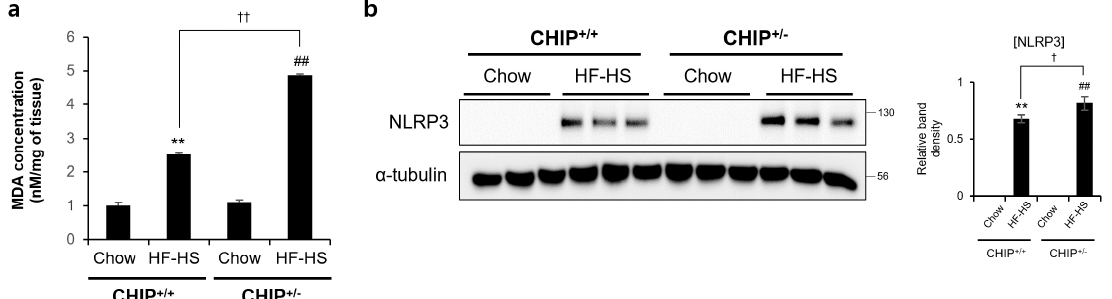
Figure 5. CHIP is responsible for high-fat and high-sucrose diet-induced oxidative stress and inflammasome formation. CHIP +/+ and CHIP +/ − mice were fed chow (11.5% fat, 0% sucrose) or the high-fat–high-sucrose (HF–HS, 36% fat, 30% sucrose) diet for 22 weeks (n = 5–7). ( a ) MDA concentrations in liver tissues were measured by ELISA method. ** p < 0.01 vs. CHIP +/+ mice with Chow, ## p < 0.01 vs. CHIP +/ − mice with Chow. †† p < 0.01. ( b ) Protein levels of NLRP3 in liver tissues were measured by immunoblotting. α -tubulin was used as a loading control. ** p < 0.01 vs. CHIP +/+ mice with Chow, ## p < 0.01 vs. CHIP +/ − mice with Chow. † p < 0.05.